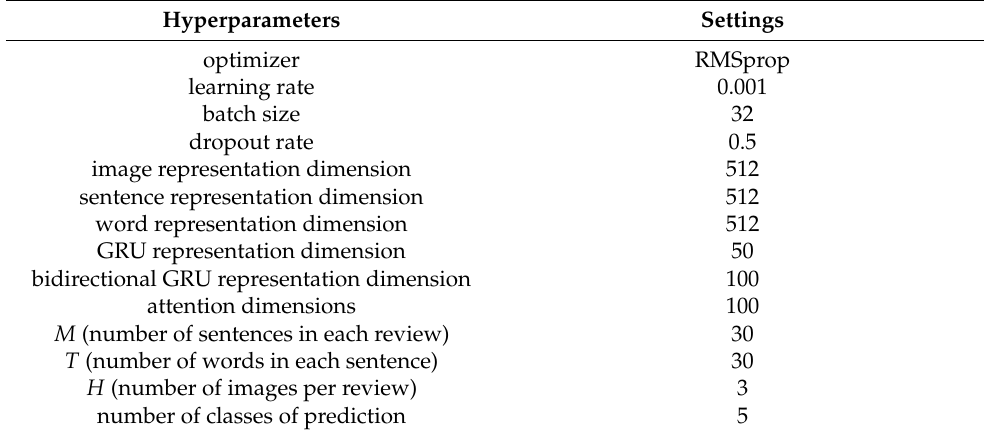
Table 2. Settings of the hyperparameters.